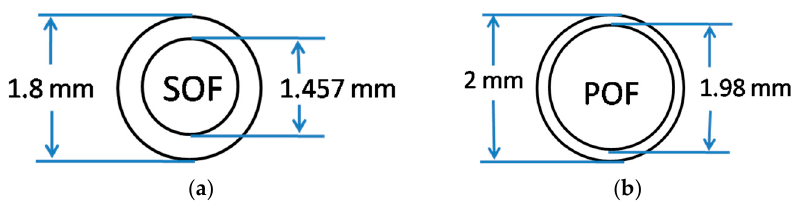
Figure 5. The dimensions of ( a ) glass optical fibers; ( b ) plastic optical fibers.